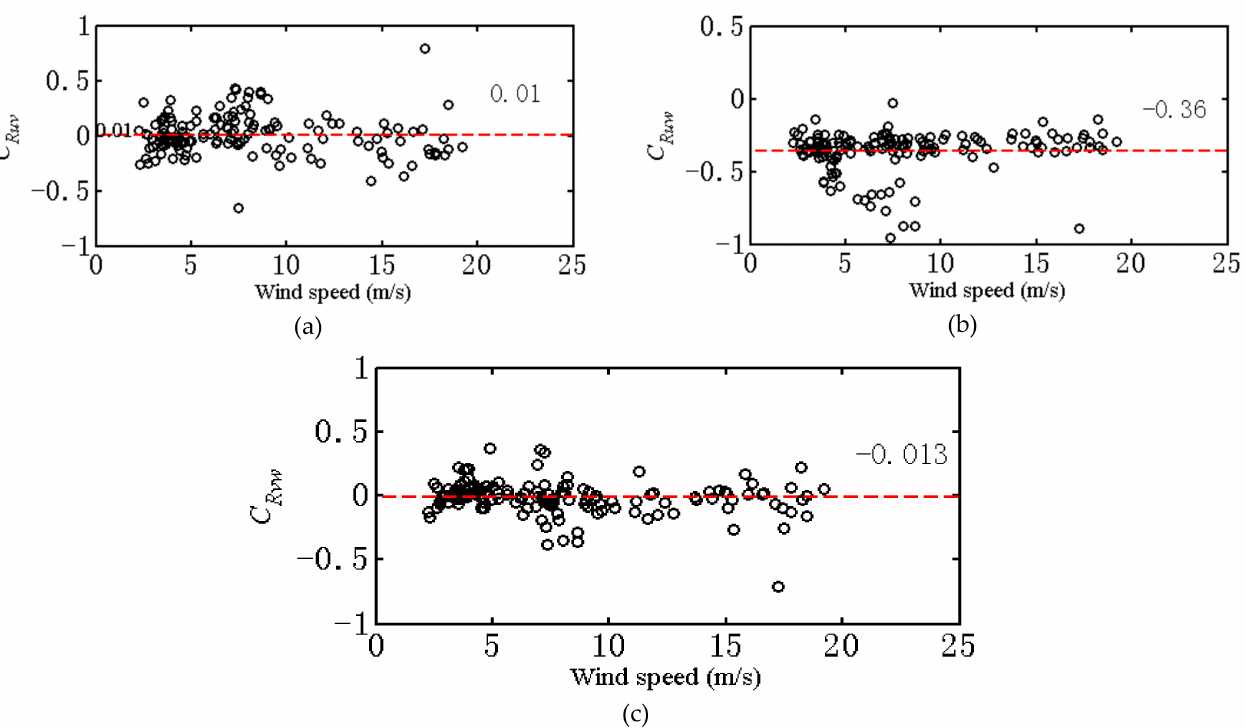
Figure 25. Correlation between the fluctuation wind speed at 10 m. ( a ) u and v directions; ( b ) u and w directions; and ( c ) v and w